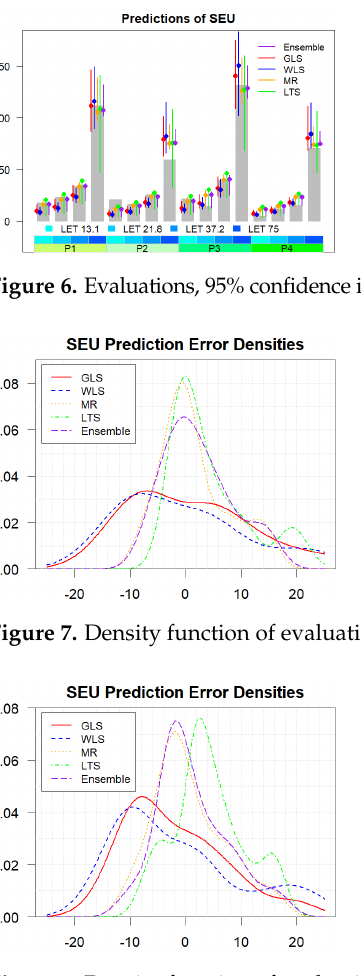
Figure 8. Density function of evaluation errors of five methods on validation set.